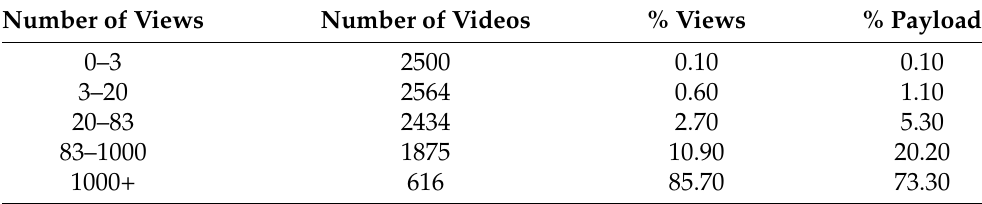
Table 4. Number of videos with corresponding percentage of total views and total